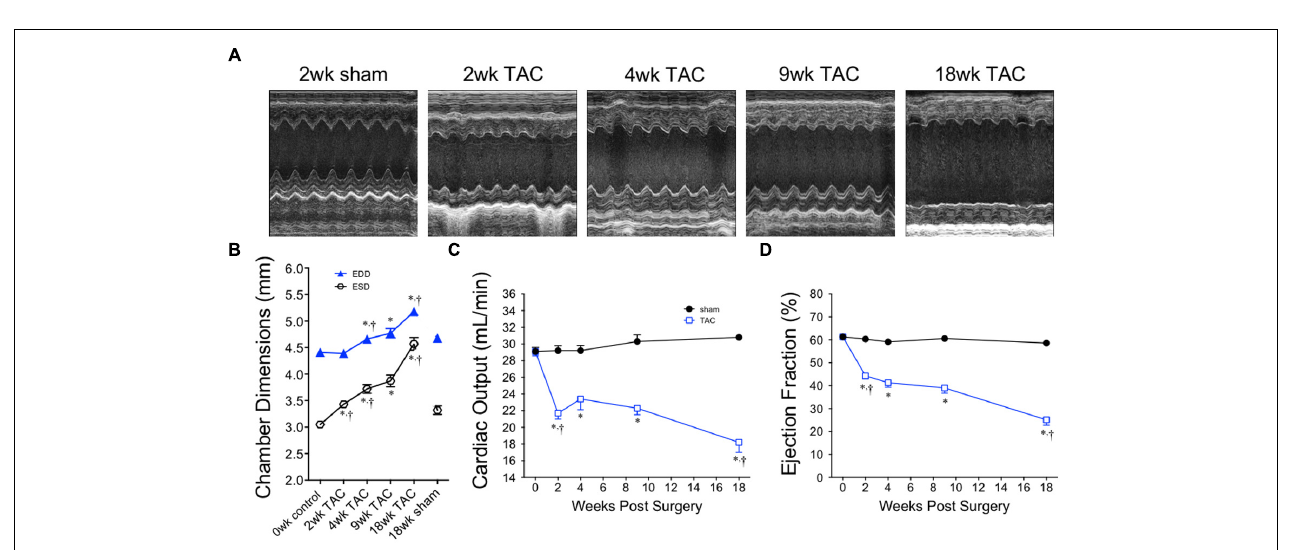
FIGURE 6 | Chamber size and echocardiographic function over 18 weeks of TAC. (A) Representative M-mode images acquired from the mid-papillary region of the LV. (B) Left ventricular end diastolic (EDD) and end systolic (ESD) dimensions, (C) cardiac output and (D) ejection fraction demonstrate dilation and a decline in cardiac function, especially between the 9 and 18 week time-points. Heart rate was statistically unchanged between all time points. ∗ p < 0.01 vs. age-matched sham. † p < 0.01 vs. previous time